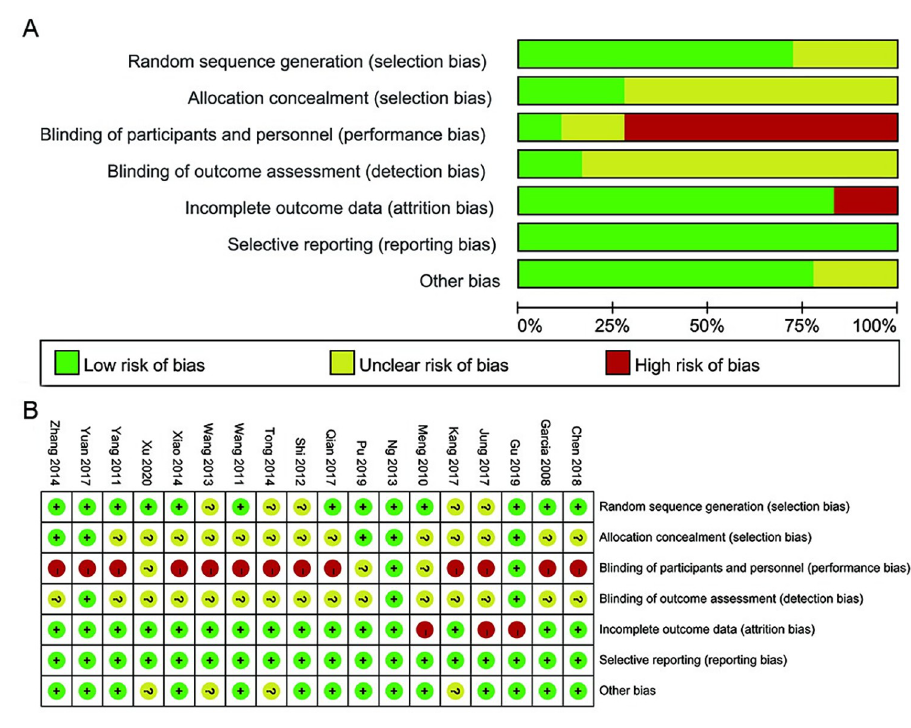
Fig 2. Risk of bias